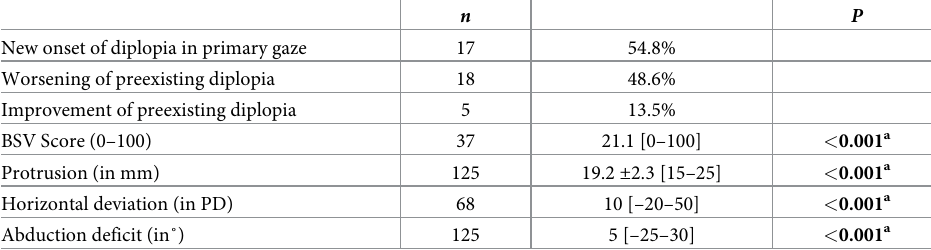
Table 2. Postoperative patient